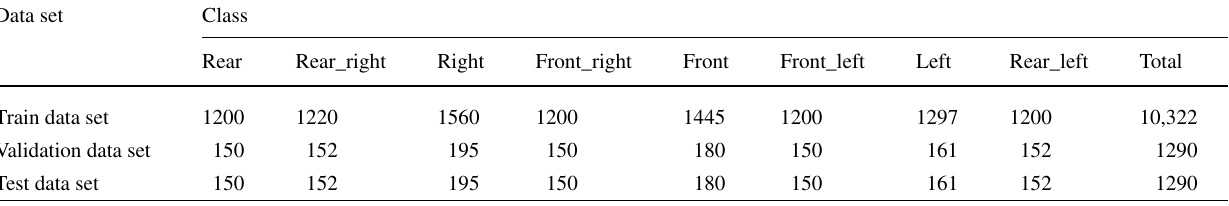
Fig. 12 Confusion matrices of various pedestrian orientation classification algorithms on the PDC data set (with augmented data